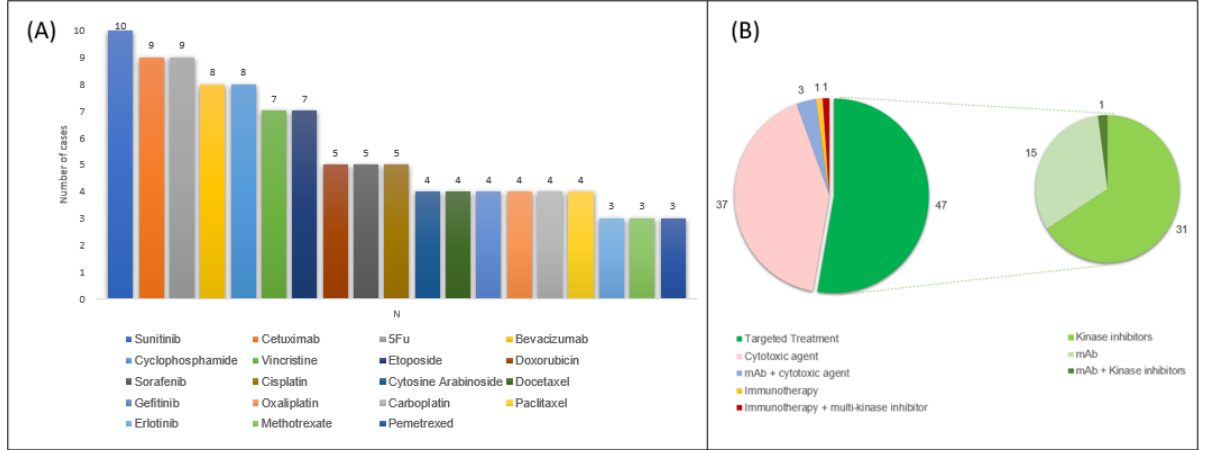
Figure 3. Anticancer therapies most commonly reported in published cases of cancer patients with PI (Panel ( A ), only reported if occurrence was found in at least 3 patients) and number of cases grouped according to pharmacological class (Panel ( B )) 5FU, fluorouracil; mAb monoclonal antibodies. Details about pharmacological treatment are reported in Table 2. Only six patients